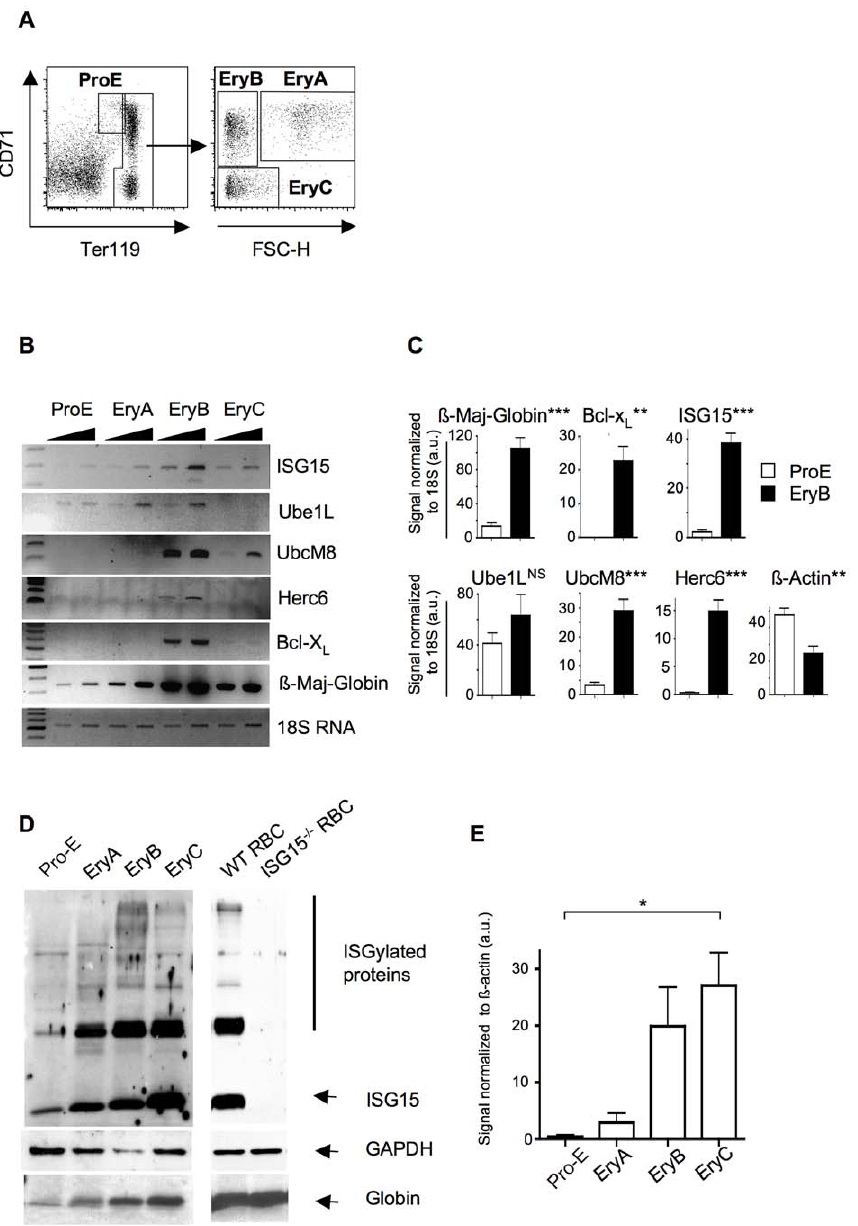
Figure 1. ISG15 expression and protein ISGylation are induced during invivo erythroid differentiation. ( A ) Sorting procedure of the different erythroblasts populations from bone marrow cells of WT Bl6/J mice. ( B ) RT-PCR analyses of ISG15, UbcM8, Herc6, Ube1L, Bcl-X L and ß-Major- Globin mRNA in sorted Pro-erythroblasts (Pro-E: large cells, CD71 high , Ter119 med ), basophilic erythroblasts (EryA: large cells, CD71 high , Ter119 high ), polychromatic (EryB: small cells, CD71 med , ter119 high ) and orthochromatic erythroblasts/reticulocytes (EryC: small cells, CD71 low , ter119 high ) as described in Mat & Met. Experiments were normalized to 18S Ribosomal RNA expression. ( C ) Statistical analysis of the induction of the expression of ß-Maj-Globin, Bcl-X L , ISG15 , Ube1L, UbcM8 and Herc6 m RNA. Quantification was performed as described in Mat & Met. Note the two-fold decreased expression of a second housekeeping gene, ß-actin during differentiation. au=arbitrary unit. ( D ) Western blot analyses of whole cell extracts of the indicated erythroid subpopulations using anti-ISG15 (top panels) antibody. Middle panels show GAPDH levels as loading control. Bottom panels show globin accumulation as detected with Ponceau staining of the membranes. Whole cell extracts were prepared from sorted wild-type bone marrow cells as in A or from RBC of WT and ISG15 -/- mice. ( E ) Statistical analysis of the induction of ISG15 at the protein level during in vivo erythroid differentiation normalized to ß-Actin. Quantification was performed as described in Mat & Met. au=arbitrary unit. doi:10.1371/journal.pone.0026068.g001 positive cells in cytocentrifugation analyses (Figure 3C and 3D). ISG15 deficiency intrinsically interferes with terminal erythroid We also observed the subsistence of immature erythroblasts in differentiation. ISG15 -/- cultures 2 days after differentiation induction (Figure 3C In the reverse experiment, the p53 -/- erythroid cell line was and quantification in Figure 3D). These results thus show that transduced with a retroviral vector expressing Flag-tagged ISG15